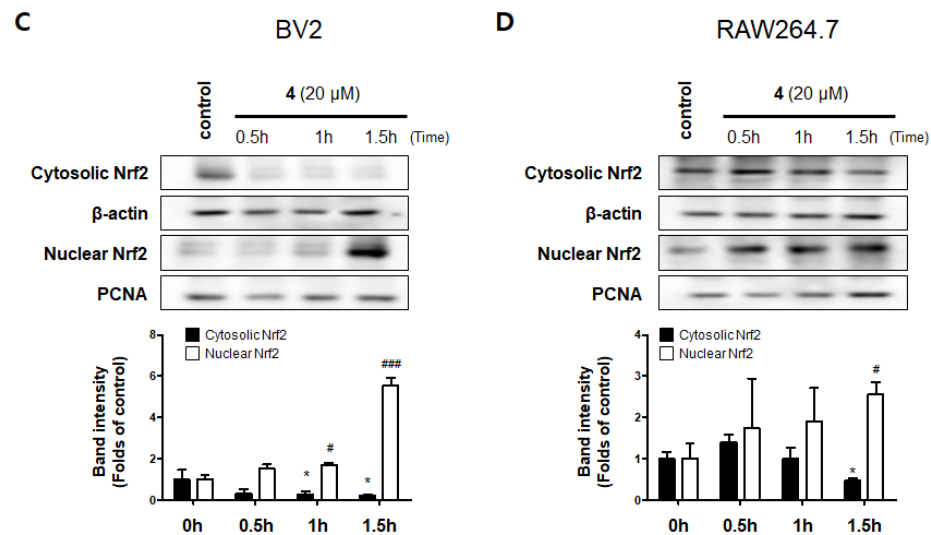
Figure 8. Effects of compounds 3 and 4 on Nrf2 activation in BV2 ( A , C ) and RAW264.7 ( B , D ) cells. The cells were treated with compounds 3 or 4 for 0.5, 1, and 1.5 h. Representative blots from three independent experiments are shown. Immunoblots were quantified using the ImageJ software. Band intensity was normalized to each β -actin or PCNA. * p < 0.05, ** p < 0.01, *** p < 0.001, #p < 0.05, ## p < 0.01, and ### p < 0.001, compared with the control group.